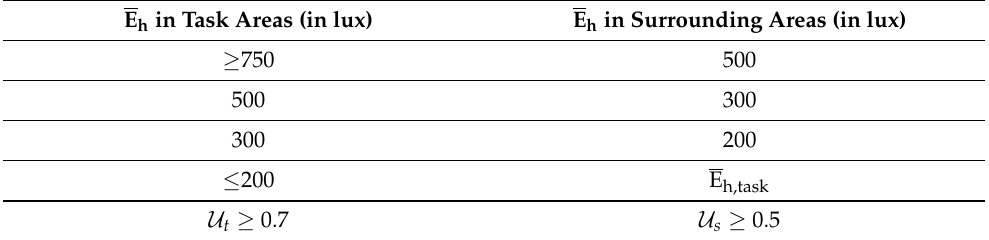
Table 1. Values of the illuminance and uniformity in the task and surrounding areas according to the standard EN 12464-1:2007